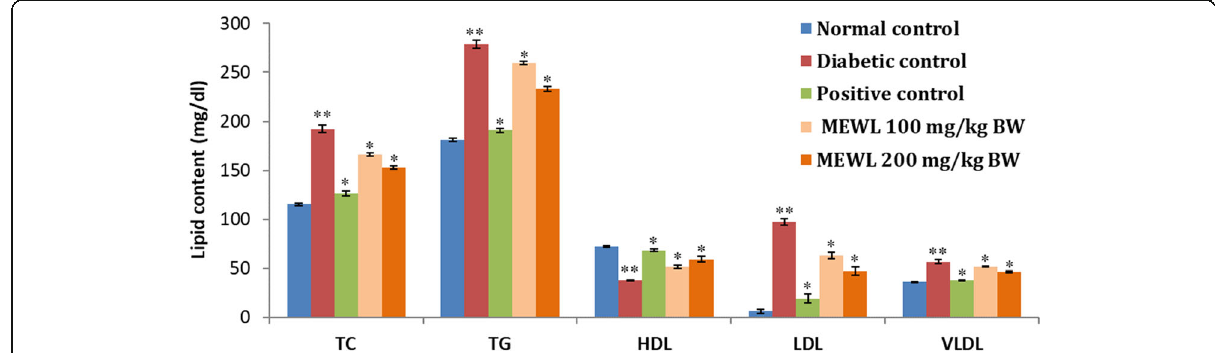
Fig. 4 Effects of MEWL treatments for 21 days on lipid profile in alloxan induced diabetic mice. All data are expressed as mean ± SEM (n; number of mice = 5). Here “ ** ” indicates p < 0.01 vs normal control mice and “ * ” indicates p < 0.01 vs diabetic control